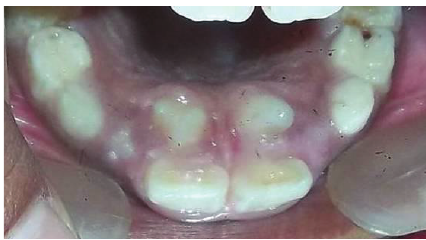
Figure 2: Intraoral photograph showing palatally erupted paired tuberculate supernumerary teeth.